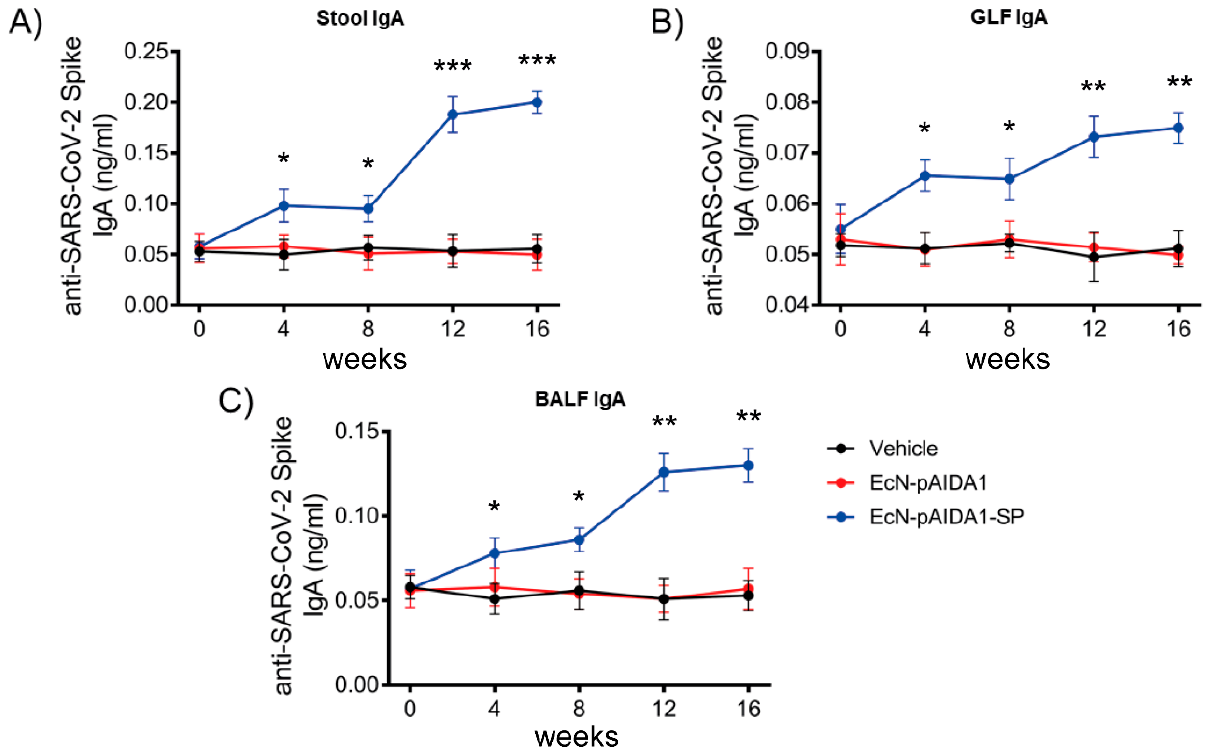
Figure 4. E. coli Nissle pAIDA1-Spike triggered IgA(s) production after oral administration. IgA titre in samples of mice treated with control (black), EcN-pAIDA1 2 × 10 9 CFU (red), and EcN-pAIDA1-SP 2 × 10 9 CFU (blue) at weeks 0, 4, 8, 12, and 16. ( A ) IgA titre in fecal samples of mice treated with gavage of PBS (black), EcN-pAIDA1 d 2 × 10 9 CFU (red), and EcN-pAIDA1-SP 2 × 10 9 CFU (blue). ( B ) IgA titre in GLF samples of mice treated with gavage of PBS (black), EcN-pAIDA1 d 2 × 10 9 CFU (red), and EcN-pAIDA1-SP 2 × 10 9 CFU (blue). ( C ) IgA titre in BALF samples of mice treated with gavage of PBS (black), EcN-pAIDA1 d 2 × 10 9 CFU (red), and EcN-pAIDA1-SP 2 × 10 9 CFU (blue). Results are expressed in mean ± SD of n = 8 experiments performed in triplicate. (* p < 0.05 vs. control group, ** p < 0.01 vs. control group, *** p < 0.001 vs. control group).